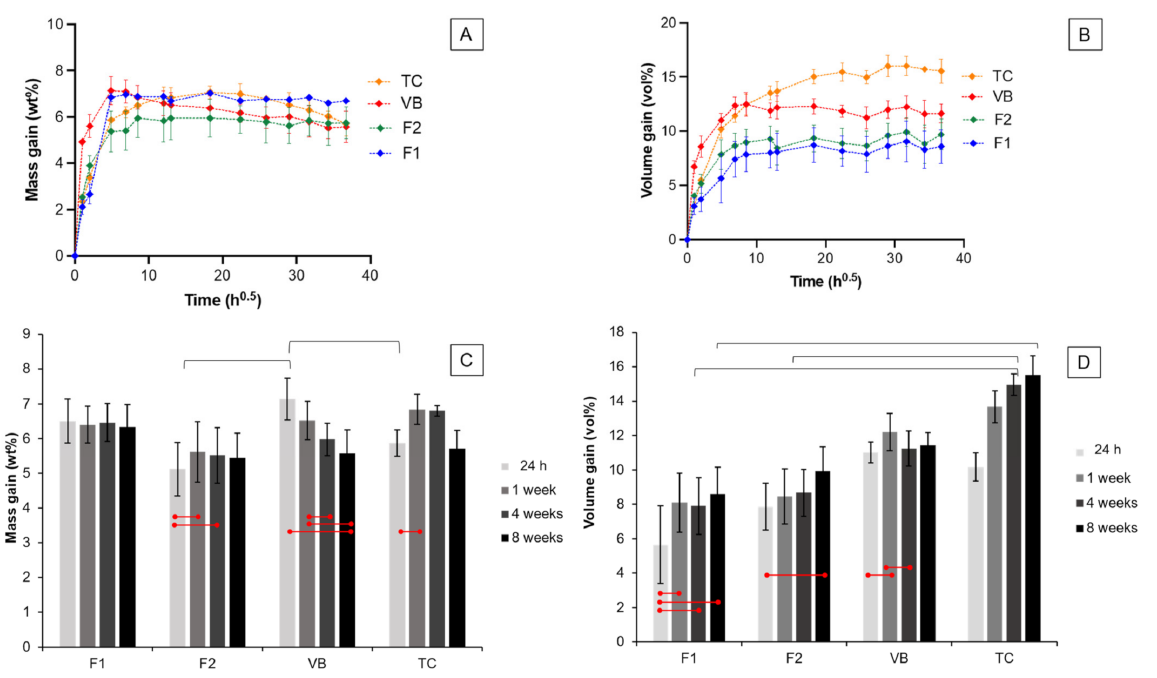
Figure 6. Plots of ( A ) mass gain and ( B ) volume gain versus the square root of time (h) for all materials after immersion in deionized water for up to 8 weeks. The ( C ) mass and ( D ) volume gains at 24 h, 1 week, 4 weeks, and 8 weeks. Error bars are SD ( n = 3). Lines indicate p <